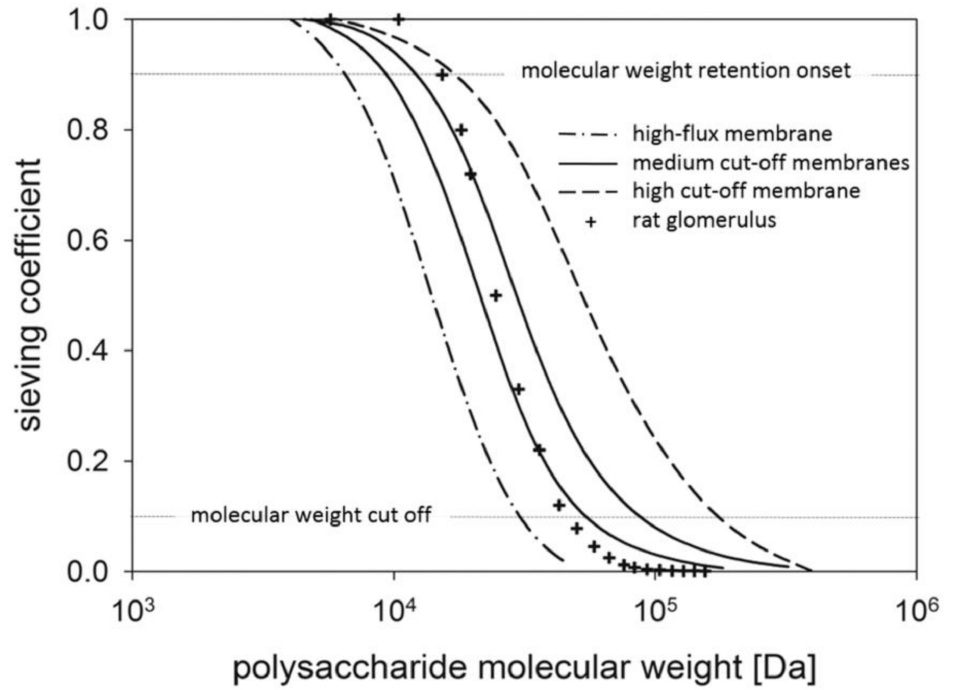
Figure 3. Sieve curves of different dialysis membranes and rat glomerulus. Sieving profile of high- flux, medium cut-off, and high cut-off dialysis membranes was determined by dextran filtration (as reported by Boschetti-de-Fierro et al. [13]). Data for glomerular membrane (as reported by Axelsson et al. [37]) were added for comparison (rat specimen, Ficoll filtration, measured in vivo). Picture is from Markus Storr